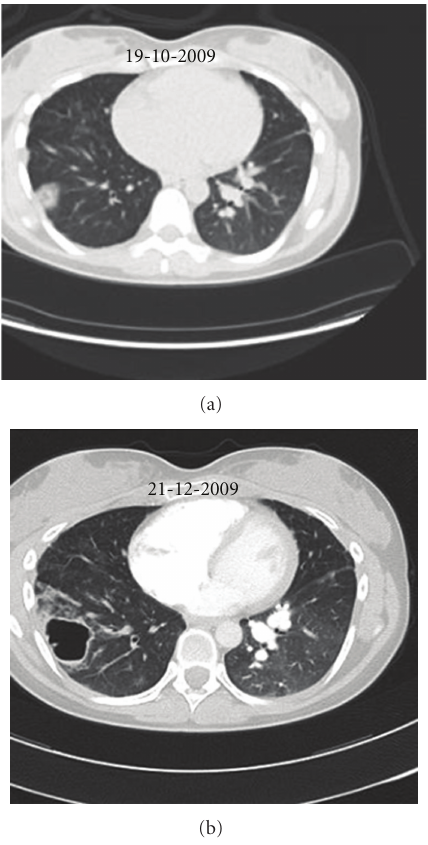
Figure 4: CT thorax shows an initial lung infiltrate (a) evolving into a large thin-walled cavitary lesion in the right lower lobe (b).